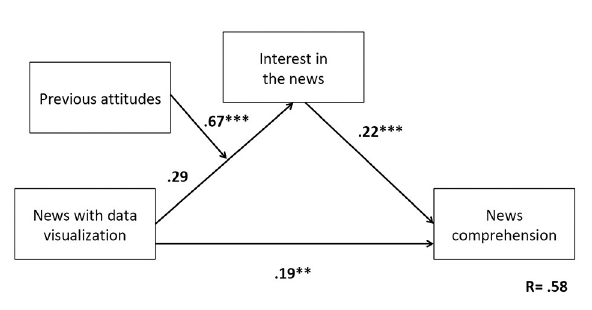
FIGURE2 Effect of previous attitudes. Model: independent variable—type of news; mediating variable—interest in the news; moderating variable—previous attitudes; dependent variable—comprehension. ** p < 0.01; *** p < 0.001.